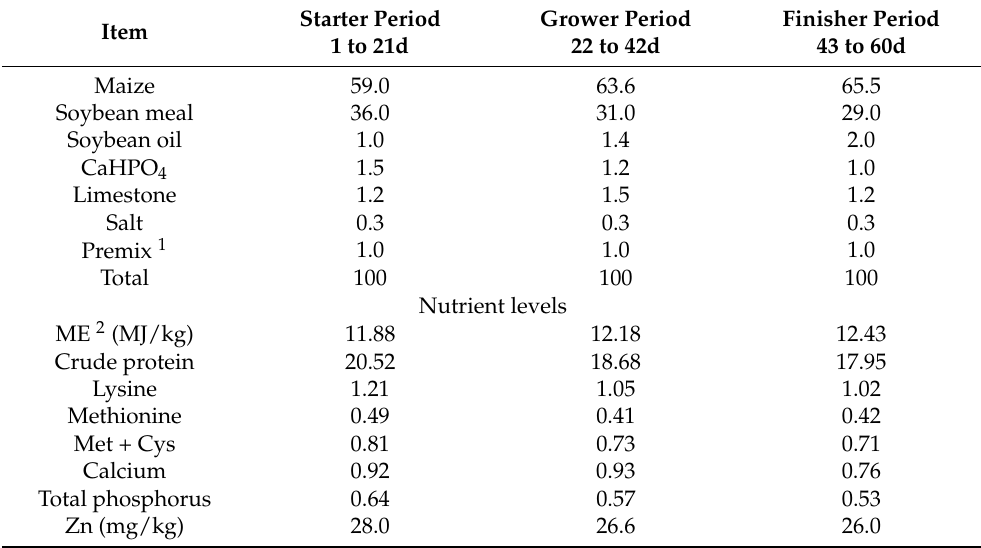
Table 2. Composition and nutrient level of the basal diet for offspring broiler (%, unless otherwise stated).